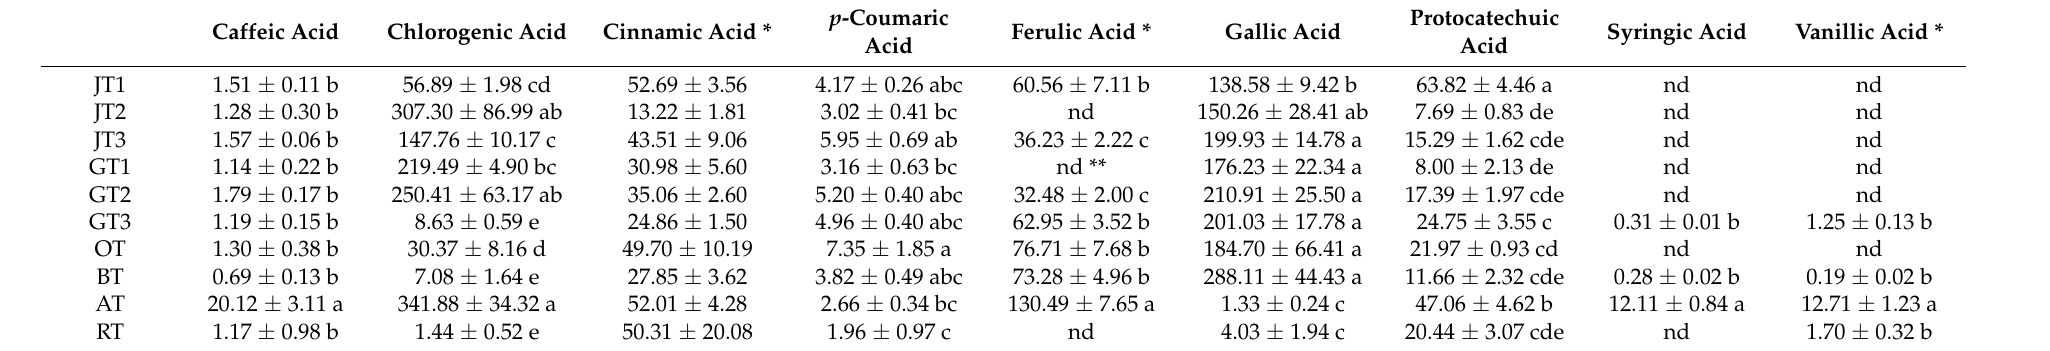
Table 3. Phenolic acids ( µ g/g) in the studied